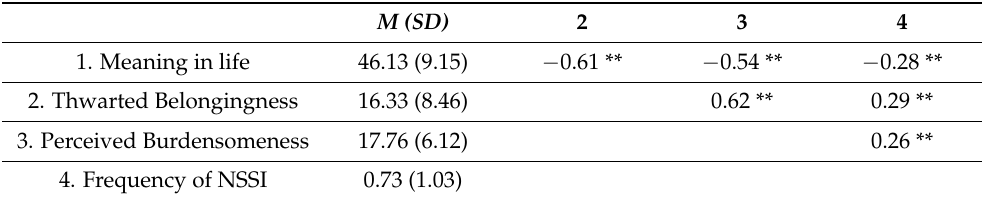
Table 1. Zero-order correlations between variables.